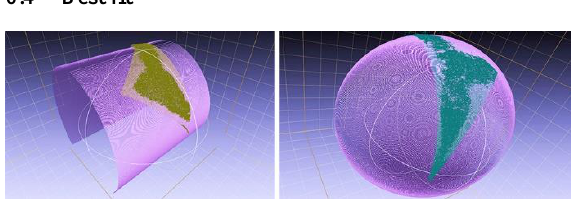
Figure 7. Ellipsoid regression of surfaces A and